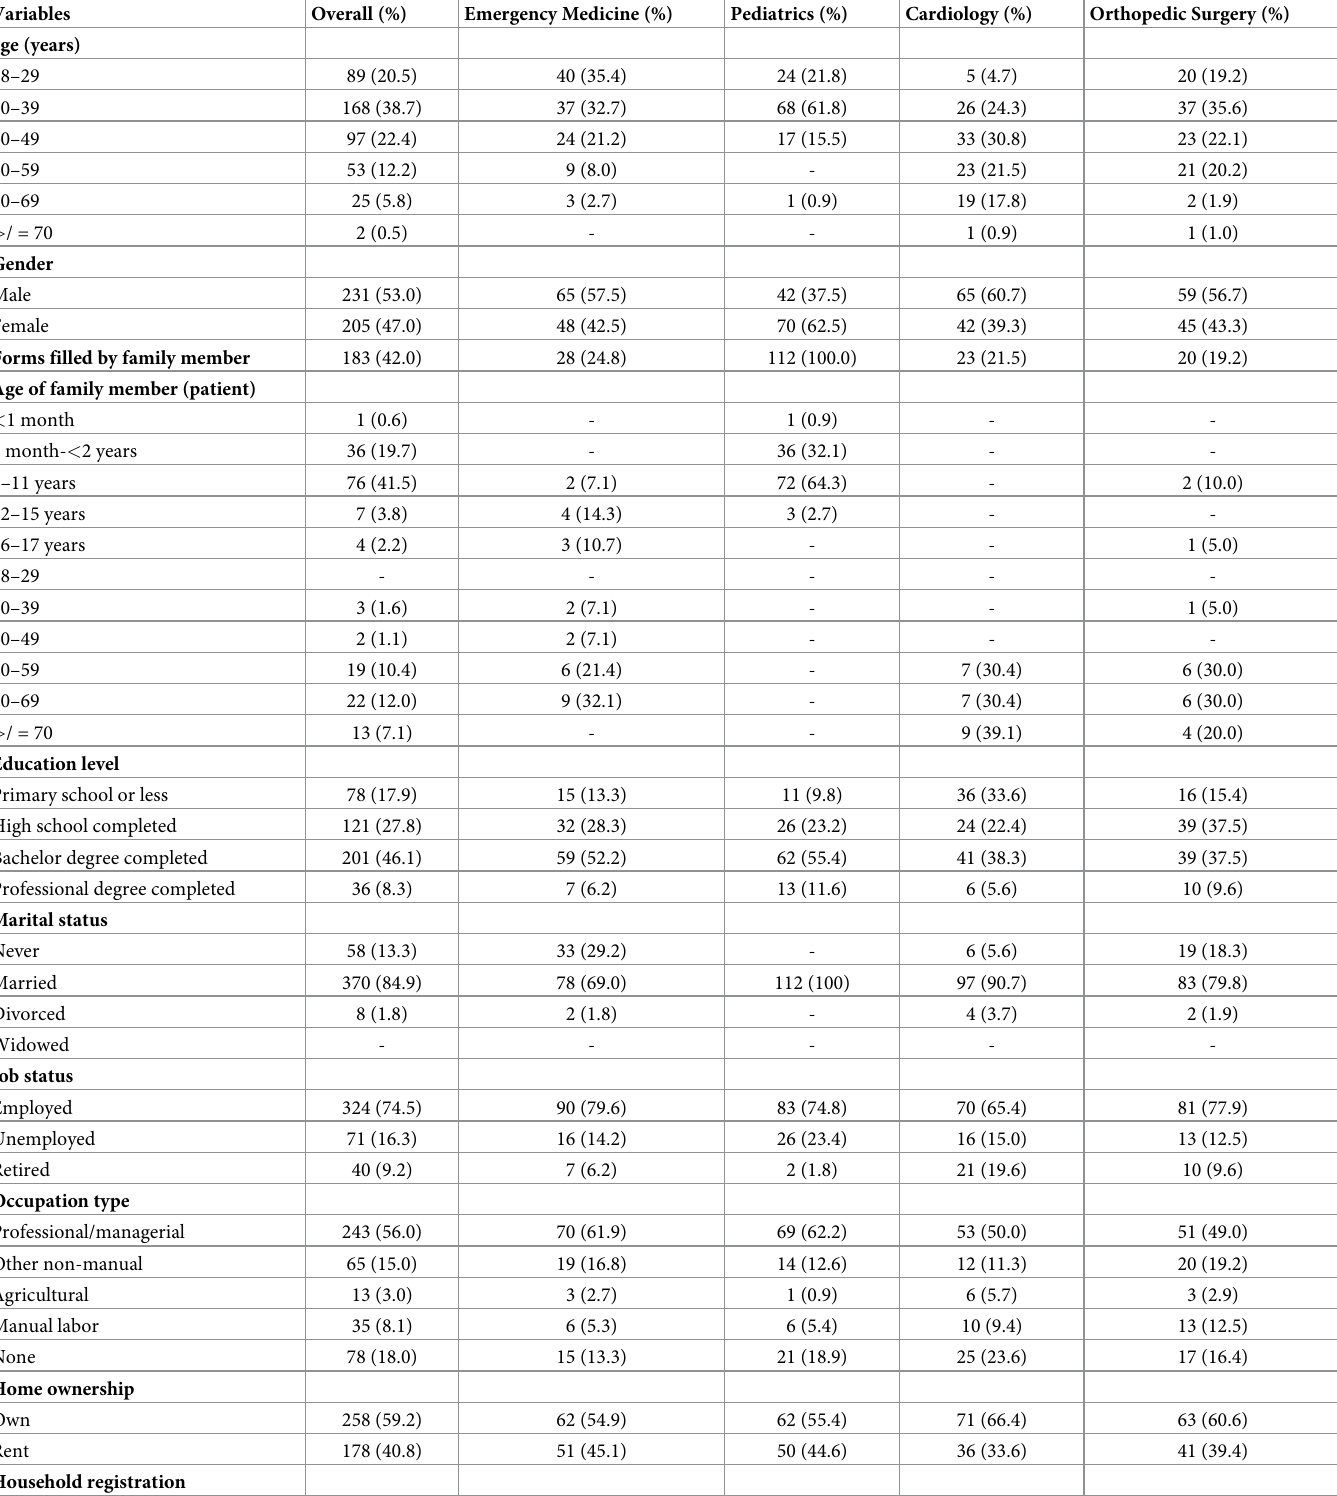
Table 1. Demographic characteristics of sampled patients in each